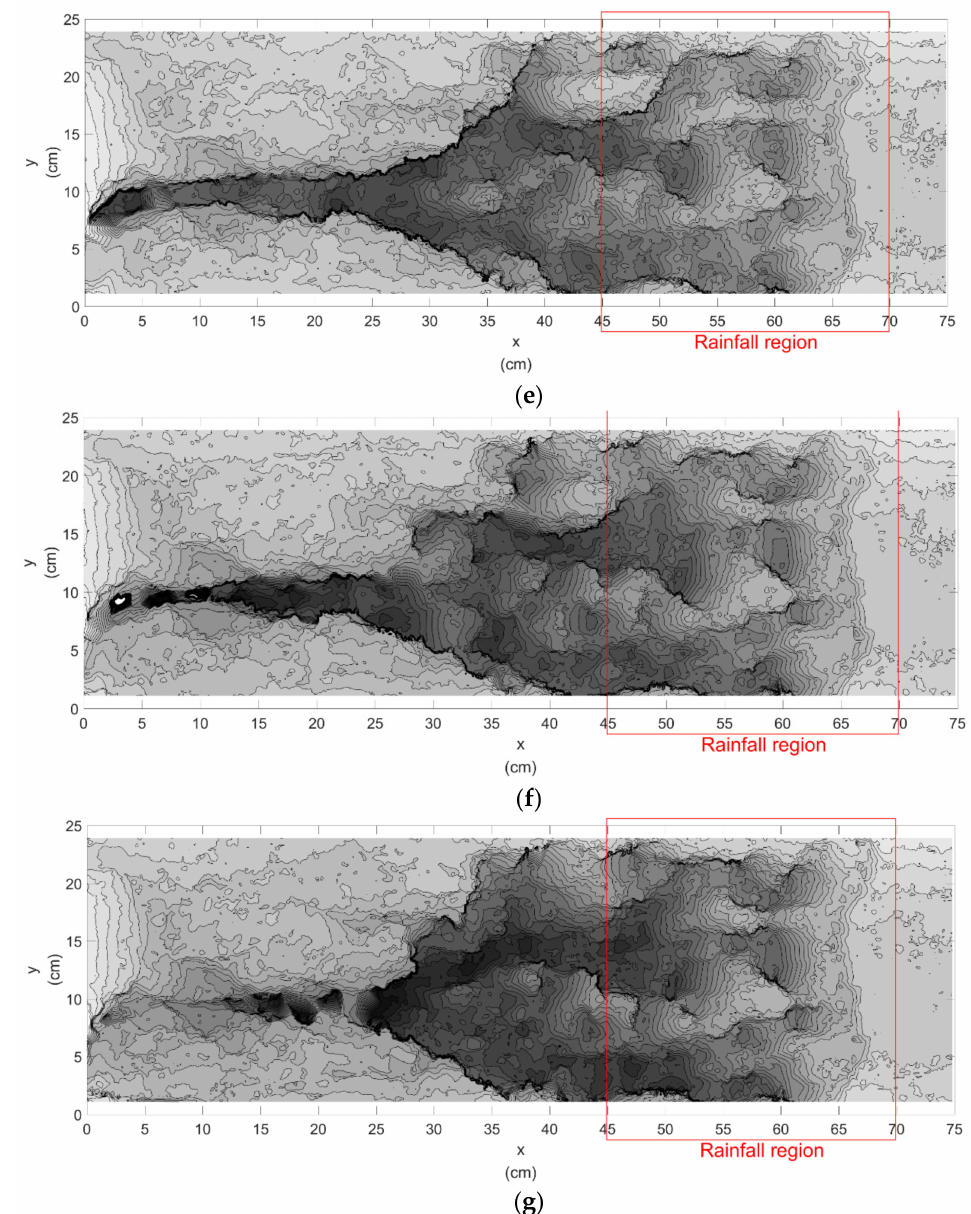
Figure 3. The laser-scanned topographies during the simulated rainfall erosion test of a 30 ◦ slope: ( a ) the initial topography before the rainfall started; the erosion topographies after ( b ) 5 min; ( c ) 10 min; ( d ) 15 min; ( e ) 20 min; ( f ) 25 min; and ( g ) 30 min of